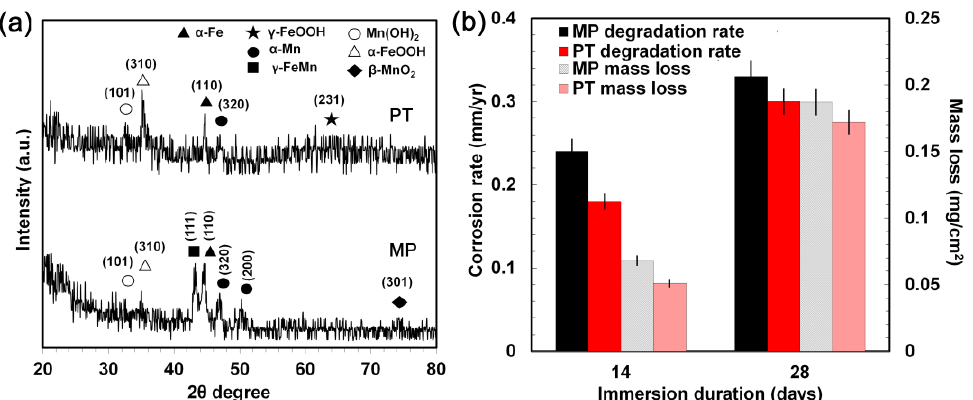
Figure 7. ( a ) Phase attribution for the MP and PT condition surfaces after the 14 day SDITs (GIXRD patterns); ( b ) static degradation rate and mass loss for the MP and PT conditions after 14 and 28 days of immersion.